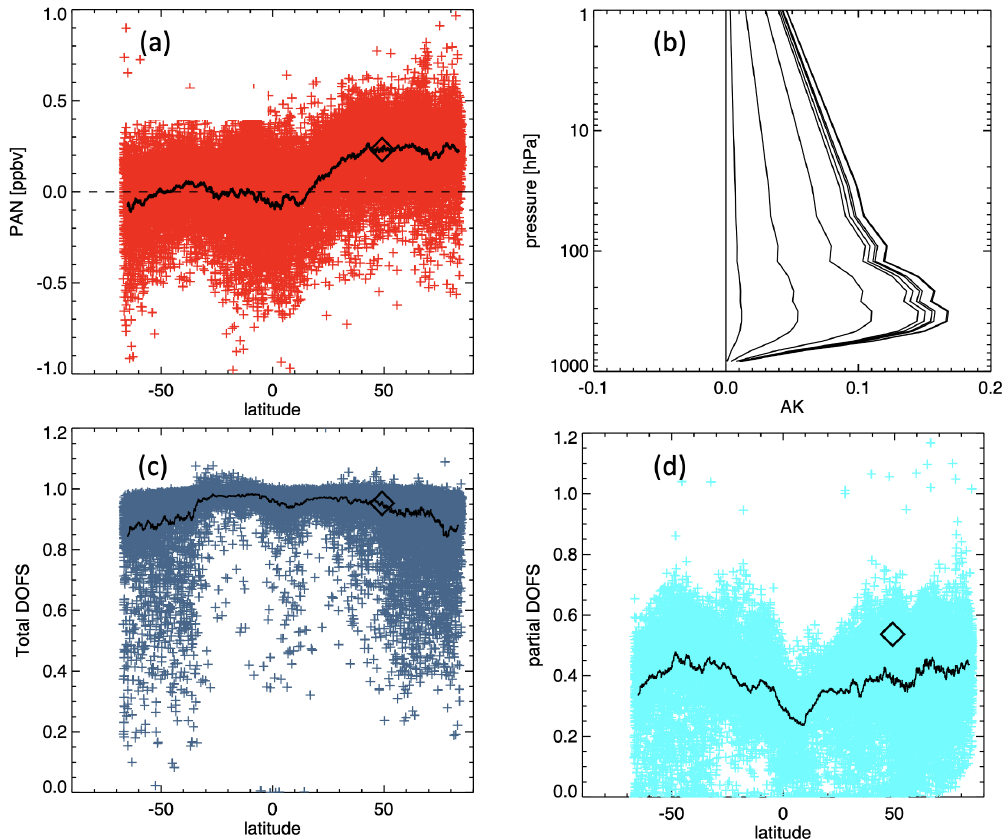
Figure 6. (a) CrIS PAN retrievals for subsampled measurements for 1 August 2020, plotted by latitude. (b) Averaging kernel for an example midlatitude case (from a point at the center of the black diamond shown in a, c, d ). Panels (c) and (d) show total and partial (825–316hPa) DOFS for retrievals from this day. In all panels, the black solid line shows a running mean over a 200-point